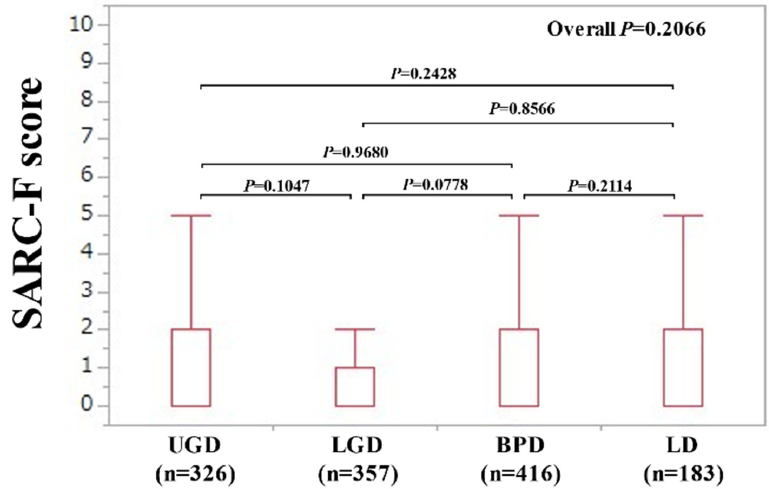
Figure 2. SARC-F score according to the diseases (upper gastrointestinal disease (UGD), lower gastrointestinal disease (LGD), biliary and pancreatic disease (BPD), and liver disease (LD)). 3.4. Proportion of Patients with SARC-F ≥ 4 Points According to Disease (UGD, LGD, BPD, and LD) The proportions of SARC-F ≥ 4 points in the disease groups were 17.5% (57/326) in UGD, 12.0% (43/357) in LGD, 17.3% (72/416) in BPD, and 13.7% (25/183) in LD ( p values: UGD vs. LGD, p = 0.0510; UGD vs. BPD, p = 1.000; UGD vs. LD, p = 0.3149; LGD vs. BPD,